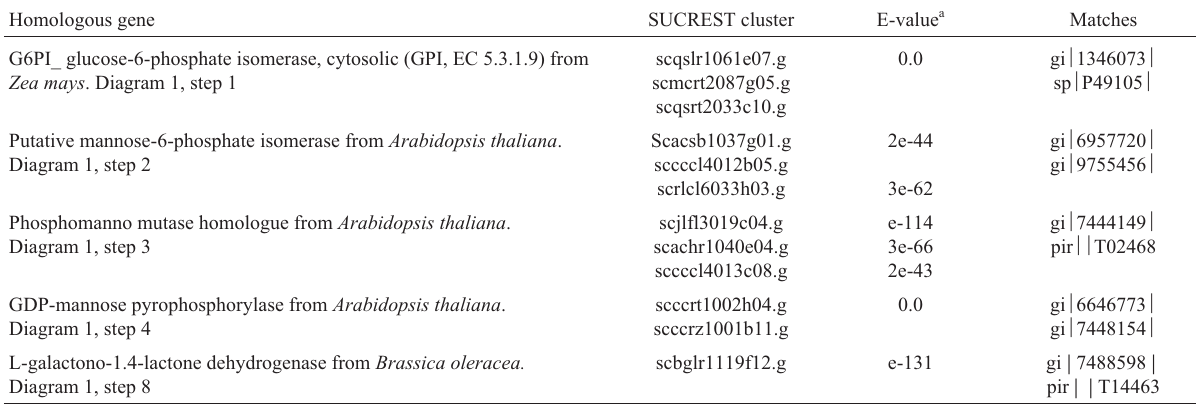
Table III - Genes involved in ascorbate biosynthesis in sugarcane.